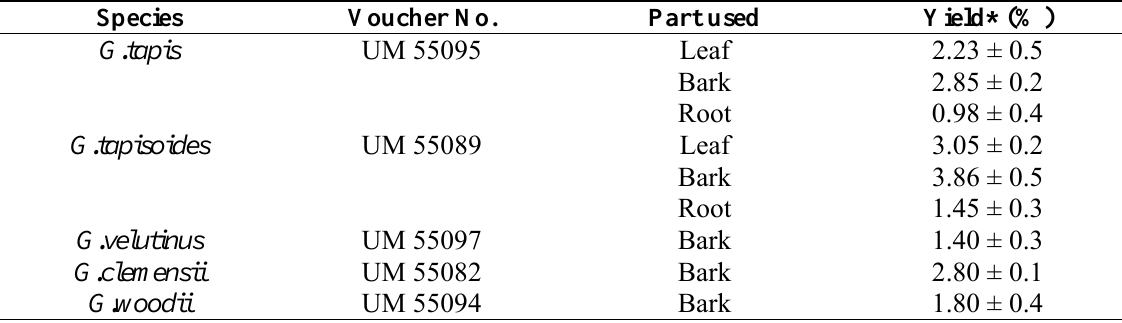
Table 1. Essential oil yields from different parts of five Goniothalamus